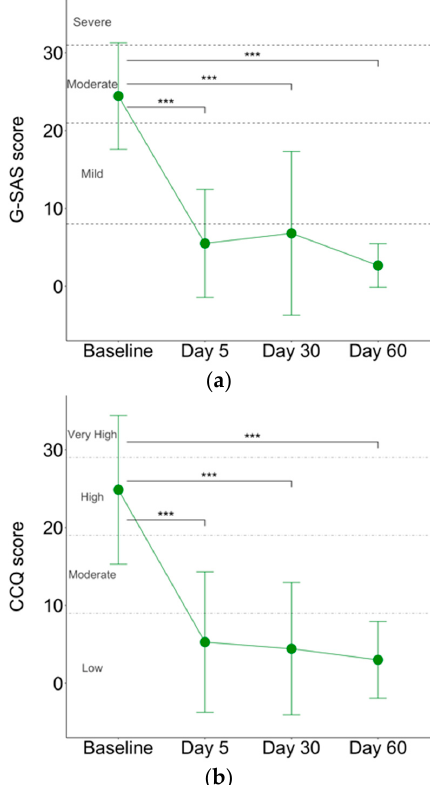
Figure 1. Plot of the means and 95% confidence intervals of ( a ) Gambling-Symptom Assessment